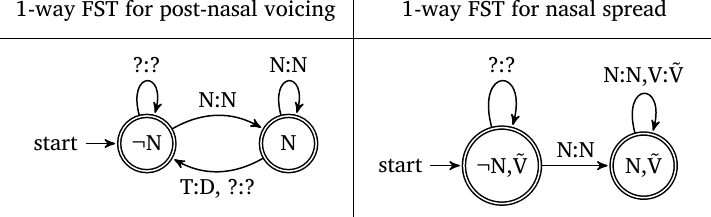
1-way FST for post-nasal voicing 1-way FST for nasal spread